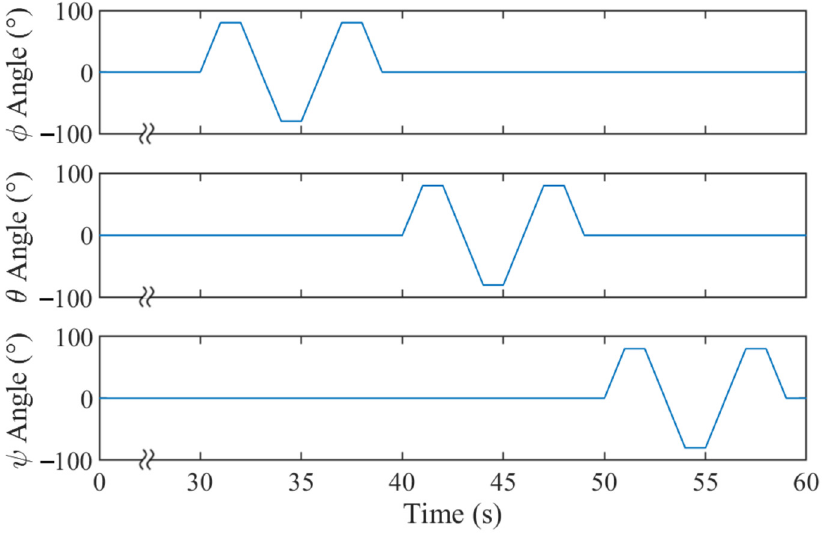
Figure 4. Plots showing the rotations about all three axes that were applied to the trackers arm for calibrating gyroscopes. The motions were performed by the robot arm in the trackers reference